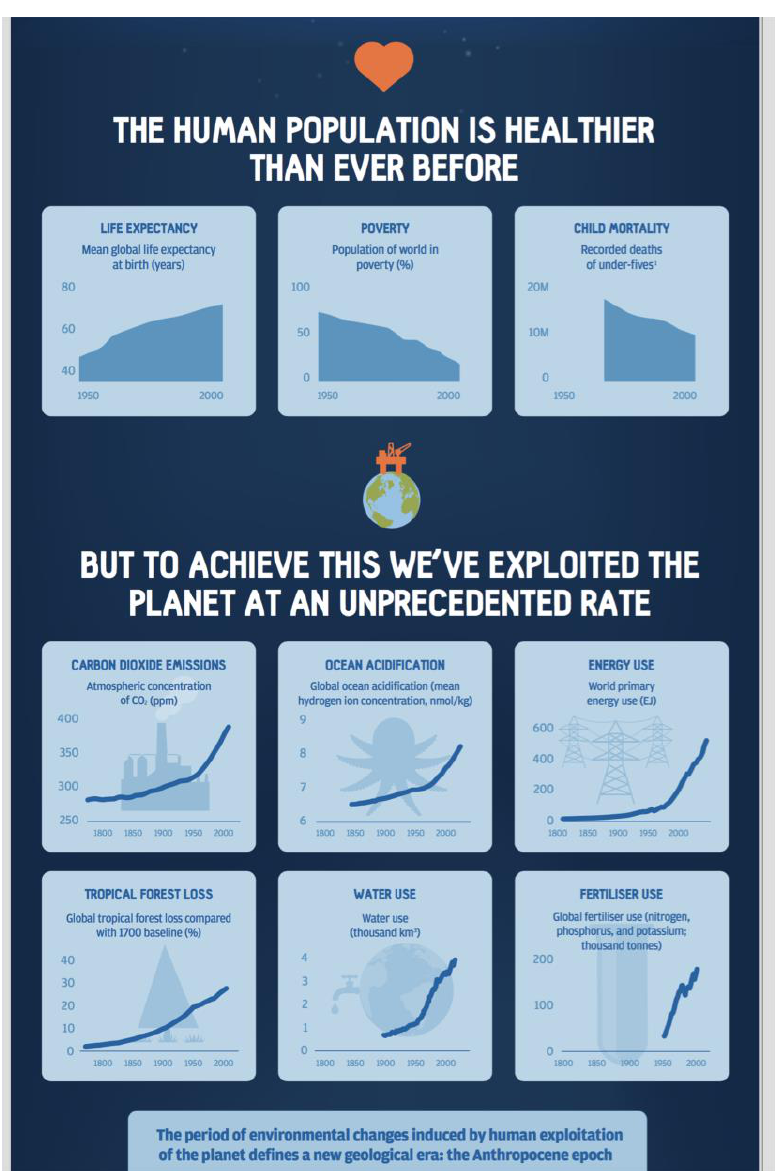
Figure 2. Screengrab of infographic from The Lancet , ‘Safeguarding Human Health in the Anthropocene Epoch: Report of The Rockefeller Foundation – Lancet Commission on Planetary Health’ (Whitmee et al. 2015